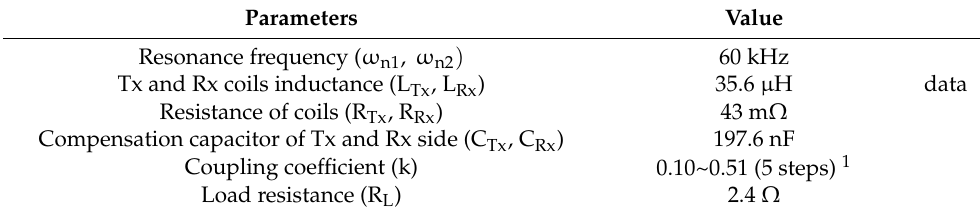
Table 5. Setup of circuit simulations.